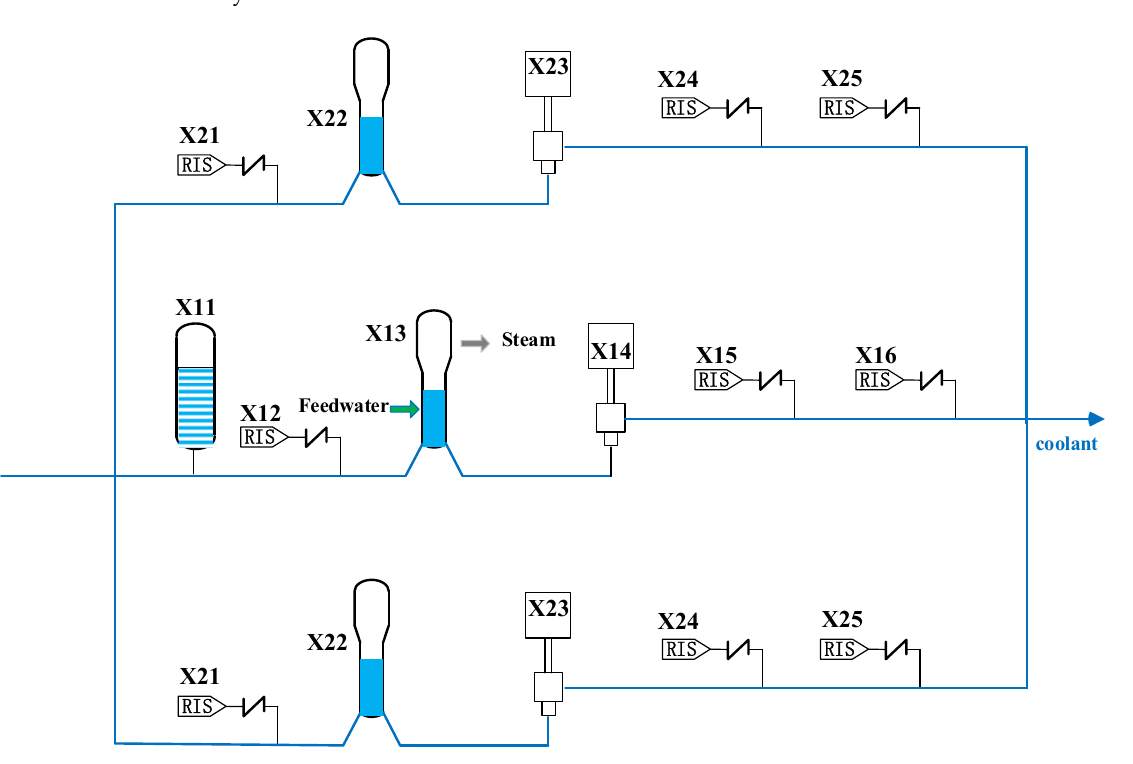
Figure A1. High-level parallel-series structure of the MCS.